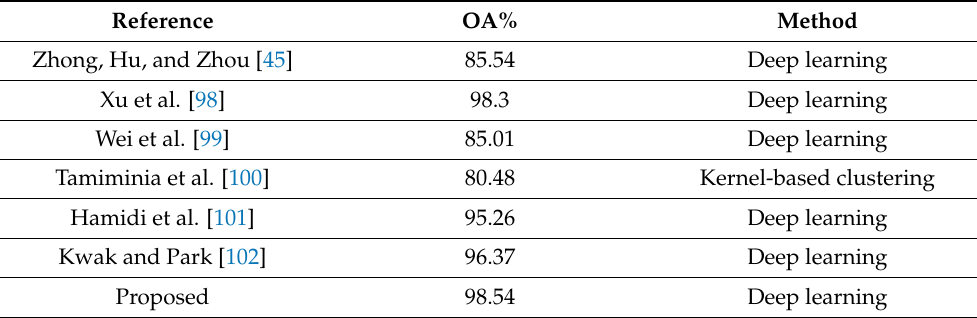
Table 6. Comparison of the performance of the proposed method with other crop mapping methods (OA: overall accuracy).